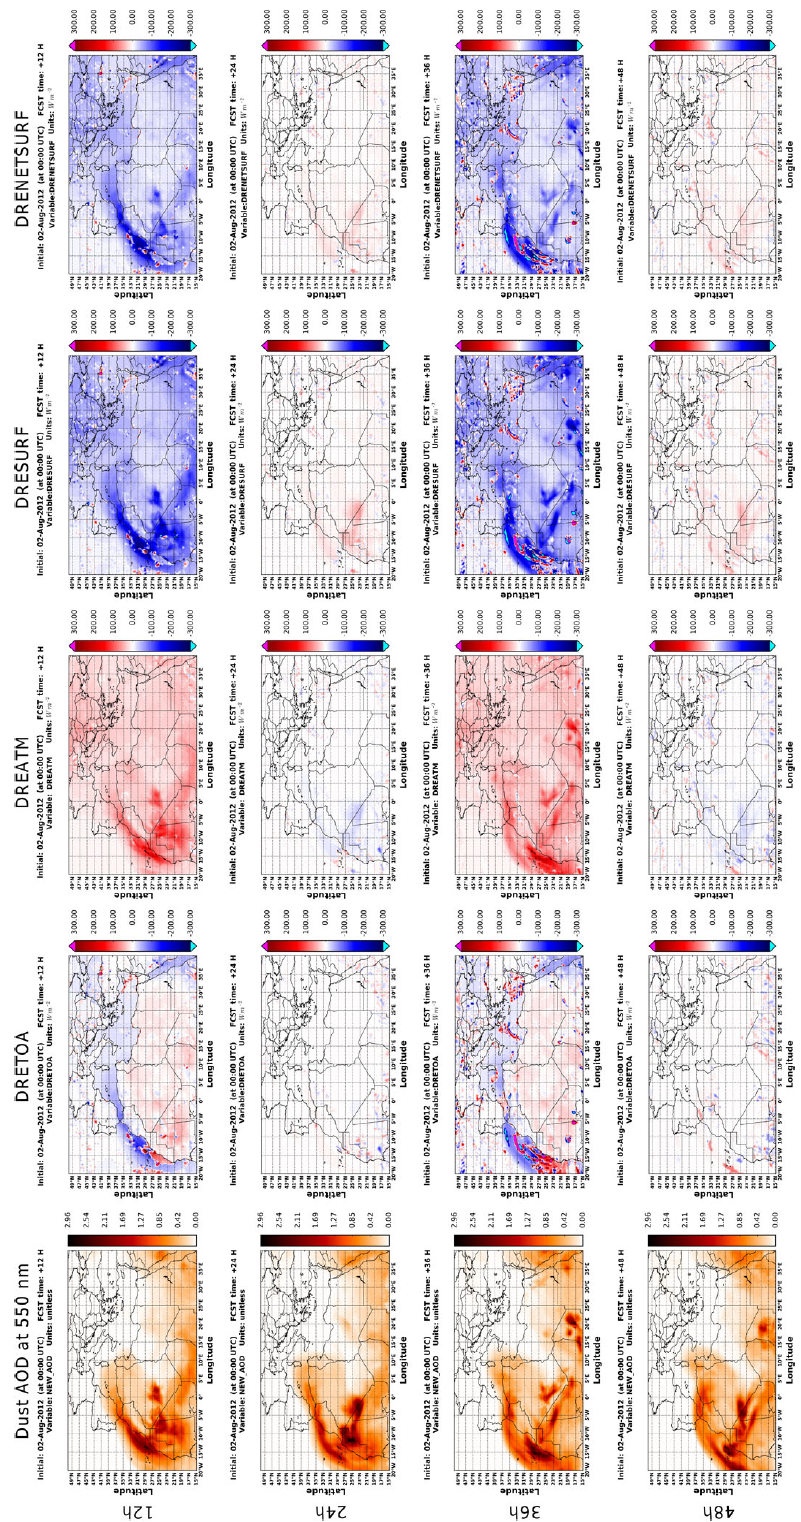
Figure 4. Spatial patterns of the simulated dust AOD 550nm and the instantaneous DRE TOA , DRE ATM , DRE SURF and DRE NETSURF values, expressed in watts per square metre (Wm − 2 ), at 12, 24, 36 and 48h after the initialization of NMMB-MONARCH model at 00:00UTC on 2 August